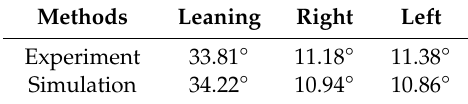
Figure 26. Arc shape image: ( a ) experiment and ( b ) simulation. Table 4. Comparison of experimentally determined and simulated arc inclination angles.